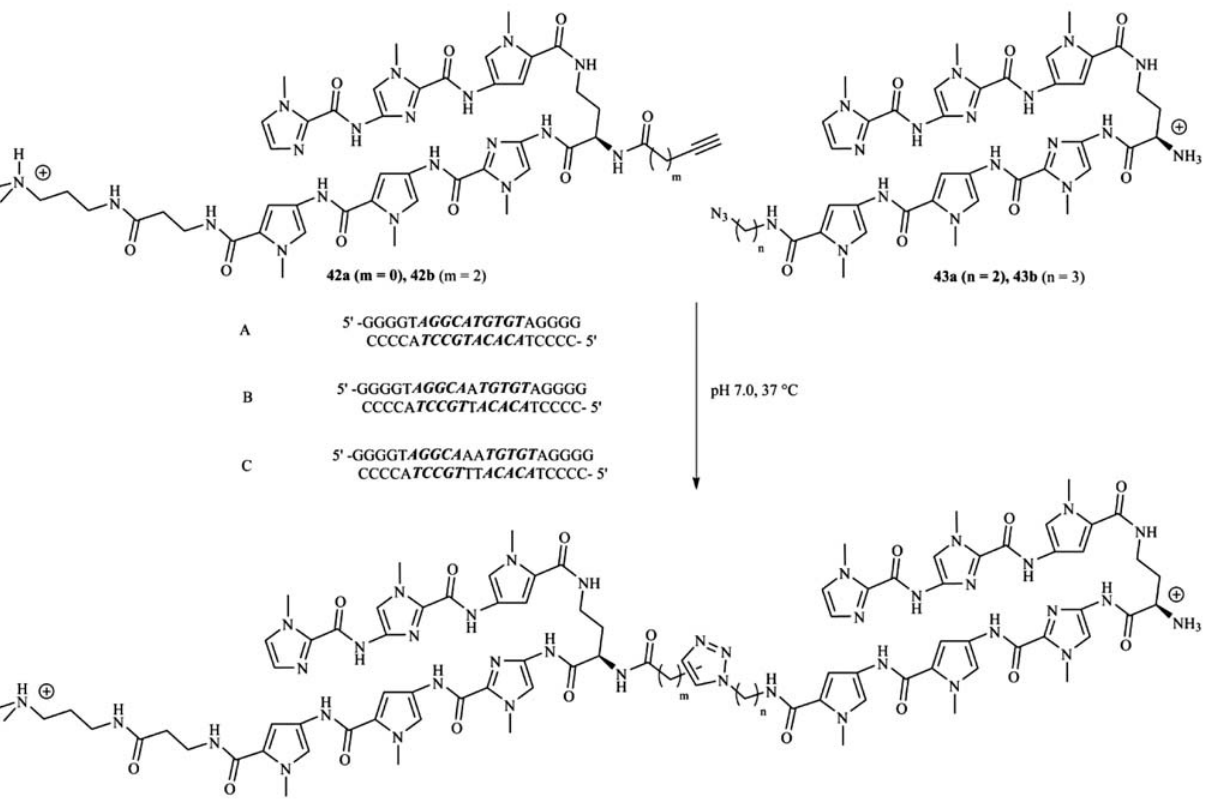
Figure 16. DNA-templated dimerization of hairpin polyamides on DNA duplexes with hairpin binding sites separated with zero (A), one (B), or two (C) base pairs.